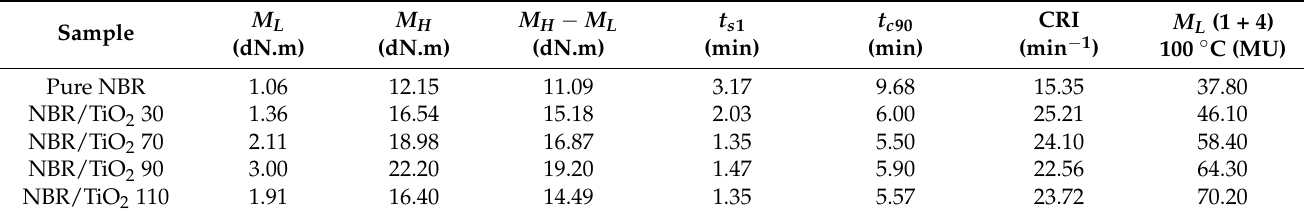
Figure 1. Cure curves of TiO 2 -filled NBR composites with various TiO 2 loadings. Table 2. Cure characteristics and Mooney viscosity of TiO 2 -filled NBR composites with various TiO 2 loadings.